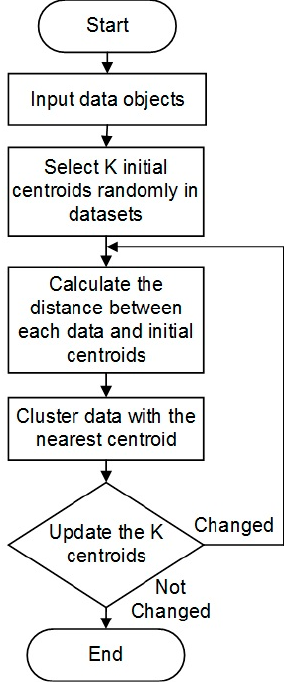
Figure 5. K-means clustering algorithm.